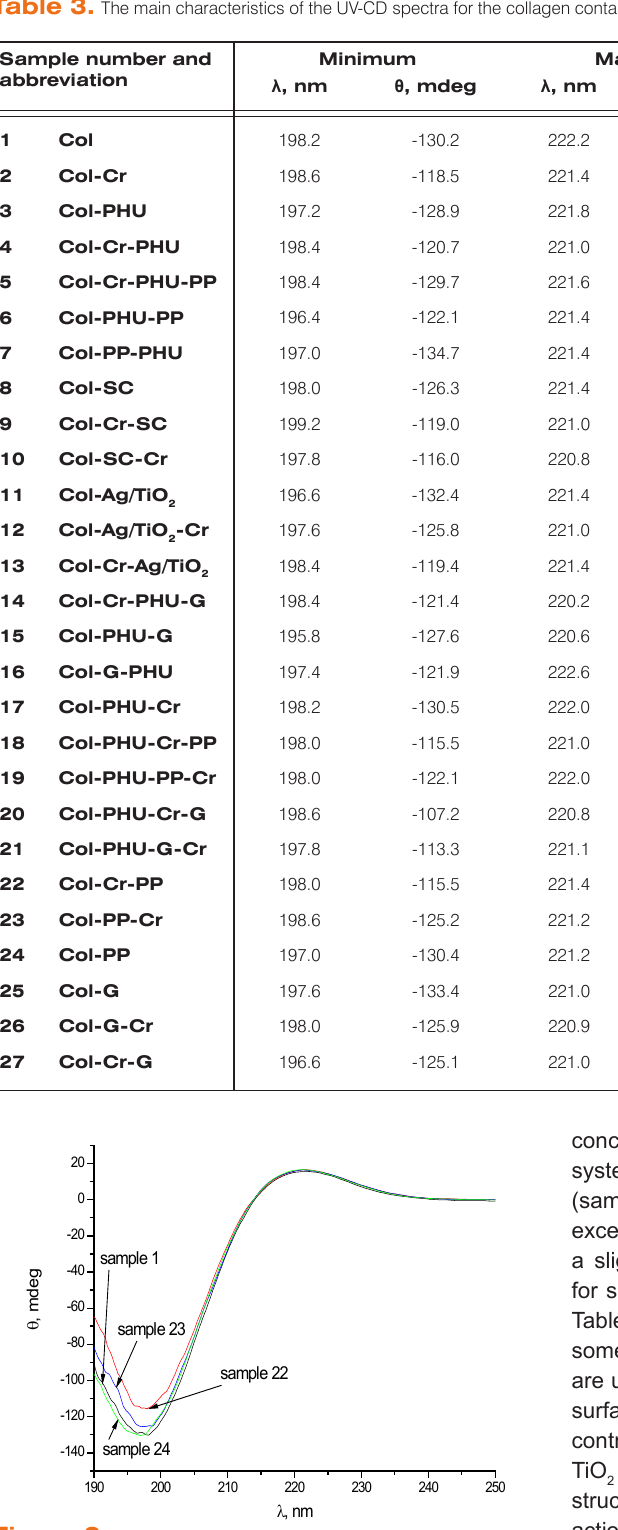
Figure 2. CD spectra of collagen contained into Col (1), Col-PP (24), Col-Cr-PP (22) and Col-PP-Cr